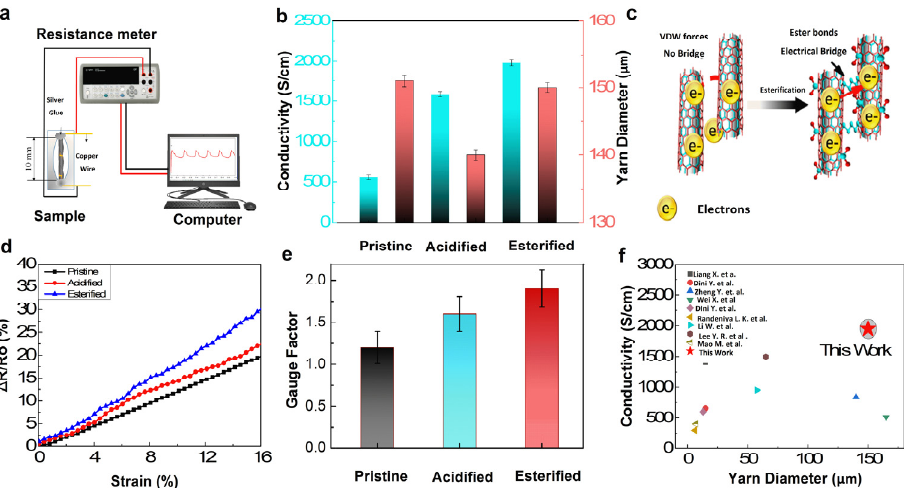
Figure 4. ( a ) Demonstration of CNT yarn specimen and its connection with resistance meter and computer; ( b ) Electrical conductivity and diameter of pristine, acidifed, and esterified CNT yarn; ( c ) Schematic diagram of the flow of electrons in cross-linked CNTs; ( d ) Relative change in resistance due to strain; ( e ) Gauge factor of CNT yarn; and ( f ) Comparison of the electrical conductivity of modified CNT yarn with previous studies.